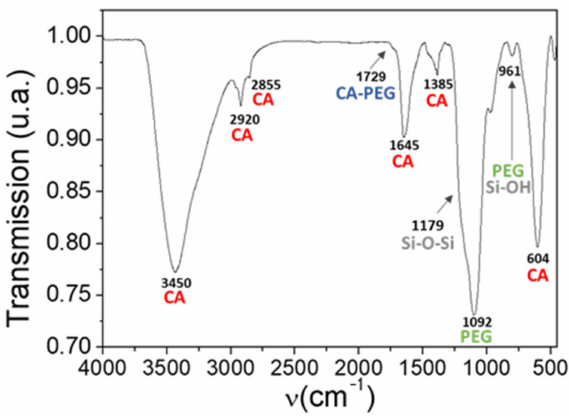
Figure 7. FT-IR transmission spectrum of hybrid nanostructures. The common peaks with FT-IR Au@PEG and IONP@CA spectra in Figure 2 are marked with red CA and green PEG labels. New peaks appear indicated in